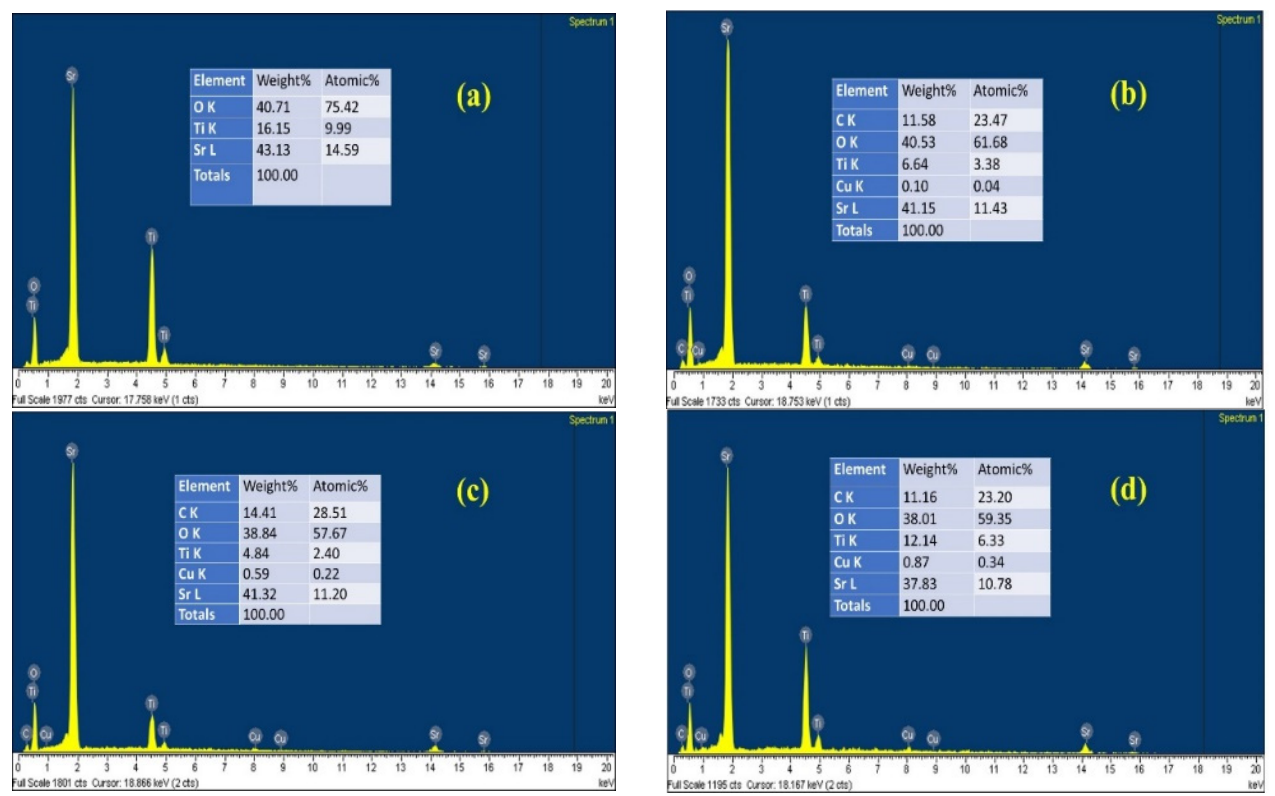
Figure 2. EDX spectra of STO ( a ), 1% CuO/STO/MWCNTs ( b ), 3% CuO/STO/MWCNTs ( c ), and 5% CuO/STO/MWCNTs ( d ).